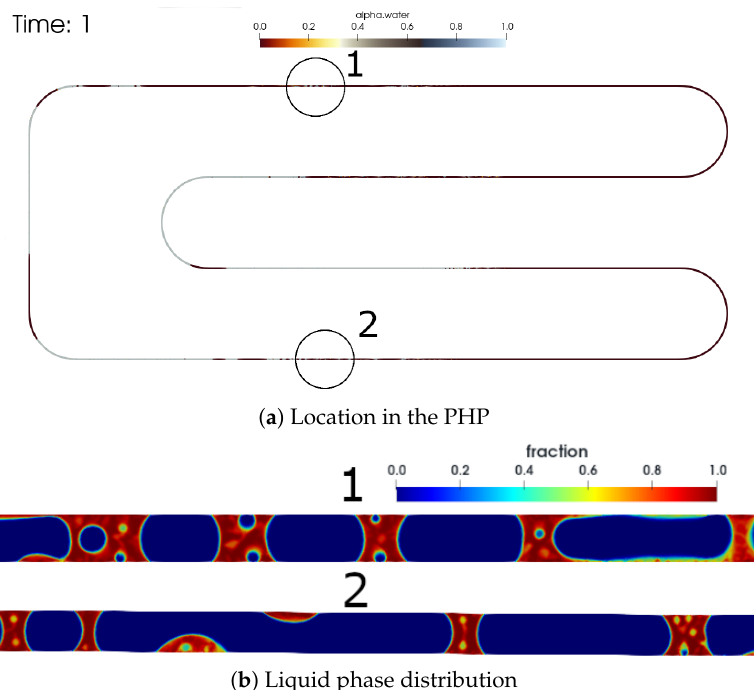
Figure 19. Numerical results of the Kafeel and Turan model [28] model in 1.0 s for 75 W input power.